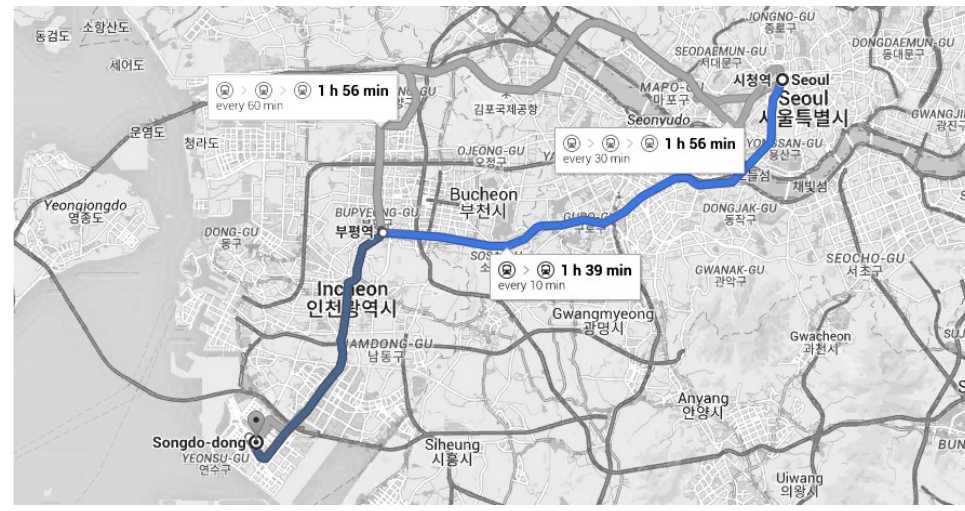
Figure 4. Commuting to Songdo by train. Source: Google Maps. Accessed December 2015.